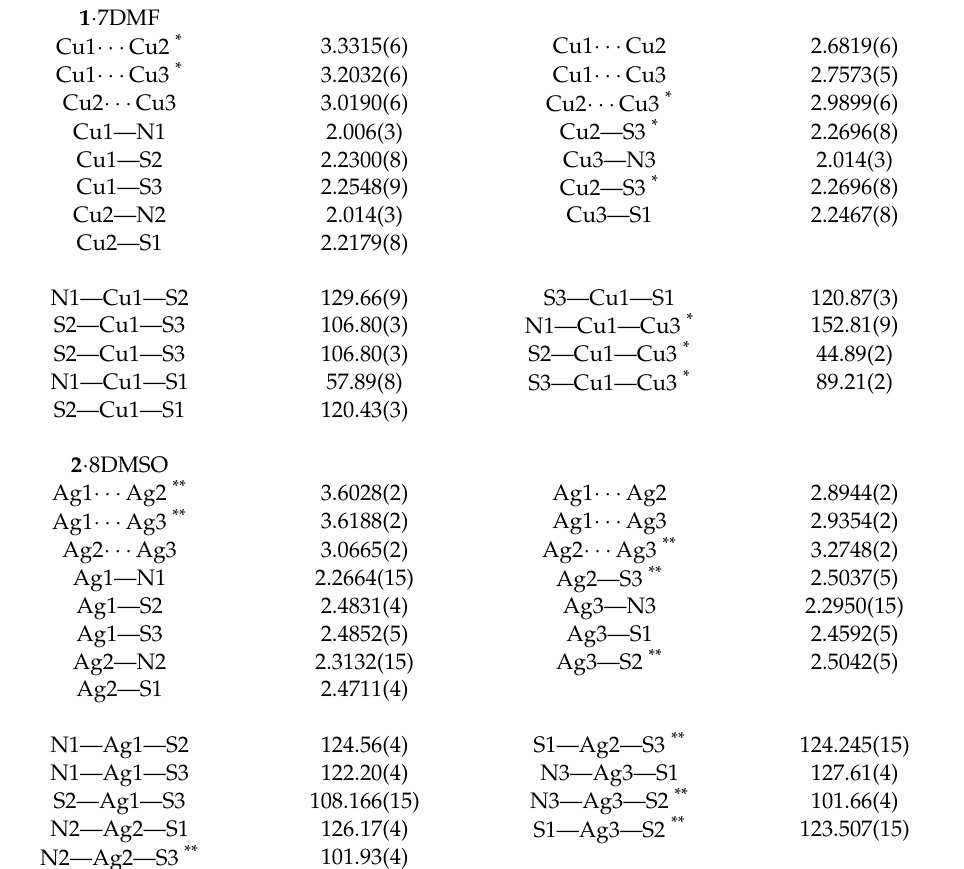
Table 2. Selected interatomic distances (Å) and bond angles ( ◦ ) for 1 · 7DMF and 2 · 8DMSO at 150